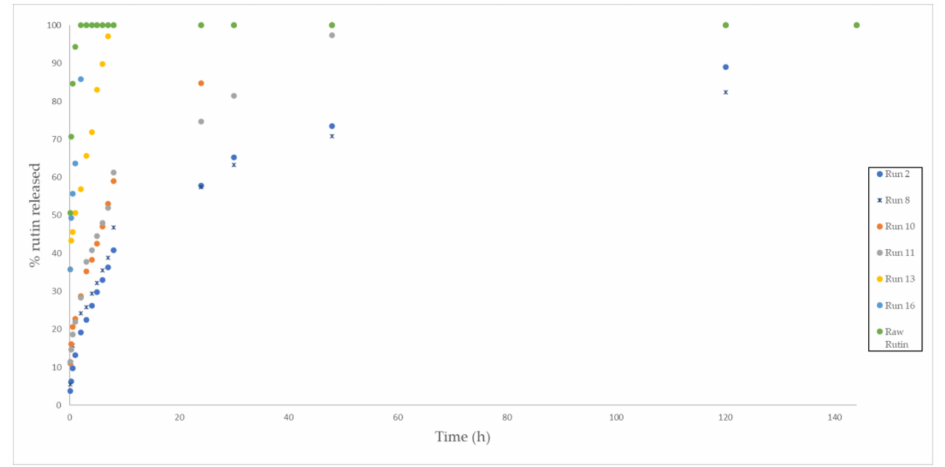
Figure 14. Rutin release profiles from the polymer foams (Runs 2, 10, 11, 13, 16, and raw rutin) into the PBS solution.